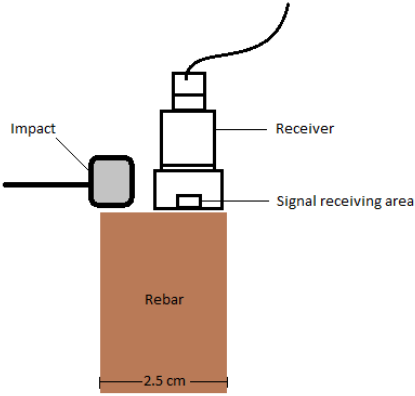
Figure 15. Configuration of Impact-echo experiment.